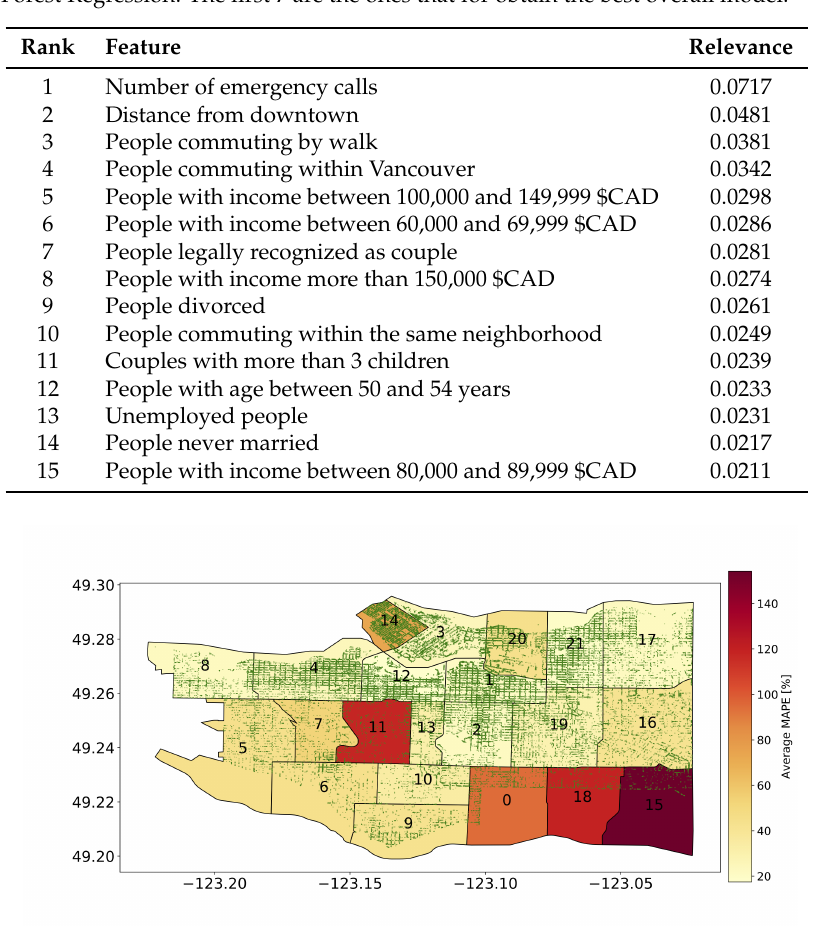
Table 3. Spatial prediction—Most relevant features and their importance for the prediction using Random Forest Regression. The first 7 are the ones that for obtain the best overall model.